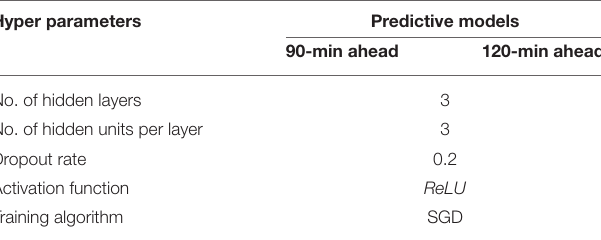
TABLE 3 | Hyperparameters of our proposed MANN